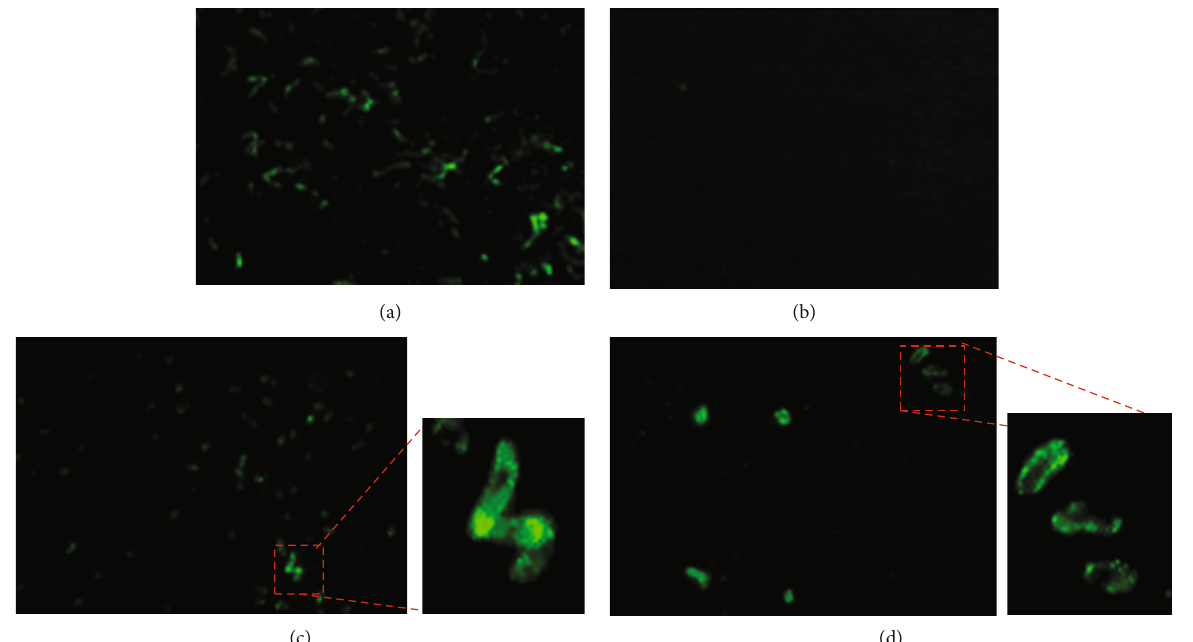
Figure 8: Enolase is exposed in surface in H. in fl uenzae typeable and nontypeable. Immunodetection by immuno fl uorescence indirect (IFI) in nonpermeabilized H. in fl uenzae typeable and nontypeable strains was realized. Anti-rNTHiENO antibodies were used as a fi rst antibody; anti-rabbit FITC-labeled IgG was used as a second antibody. Each image is a representative of at least three independent experiments and captured by a fl uorescence microscope. (a) H. in fl uenzae nontypeable (HiBUAP96) with anti- H. in fl uenzae polyclonal antibodies as a positive control. (b) H. in fl uenzae nontypeable (HiBUAP96) with preimmune sera as a negative control. (c) H. in fl uenzae nontypeable (HiBUAP96) with anti-rNTHiENO polyclonal antibodies; the inset shows a digital ampli fi cation (300%) carried out with the ZEISS ZEN lite 2.1 program in order to appreciate the recognition of anti-NTHiENO antibodies in the HiBUAP96 membrane. (d) H. in fl uenzae type b (HiBUAPNAN) with anti-rNTHiENO polyclonal antibodies; the inset shows a digital ampli fi cation (300%) carried out with the ZEISS ZEN lite 2.1 program in order to appreciate the recognition of anti-NTHiENO antibodies in the HiBUAPNAN